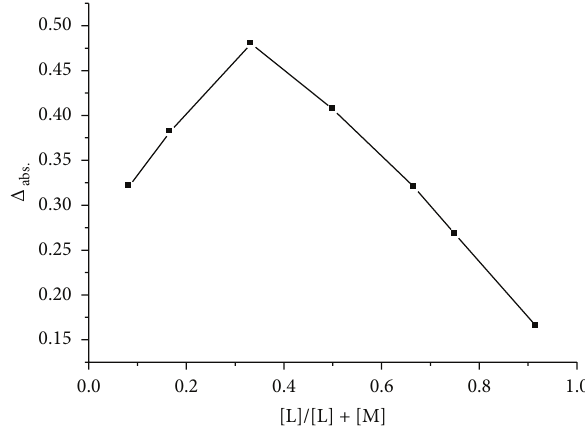
Figure 2: Job’s plot for reaction of complex A with glycyl-L-alanine ( L 1 -L 󸀠 H ) at the wavelength